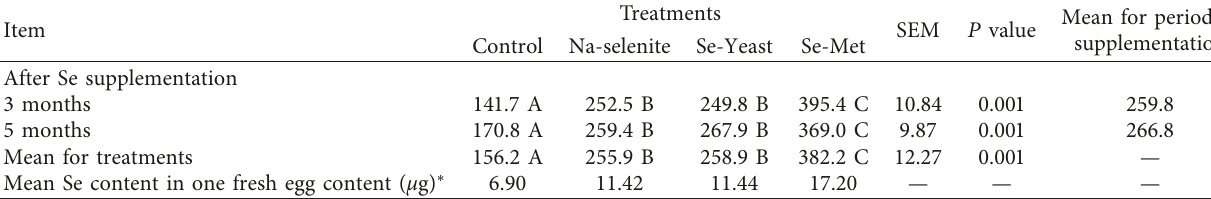
Table 3: Se content in fresh egg content ( μ